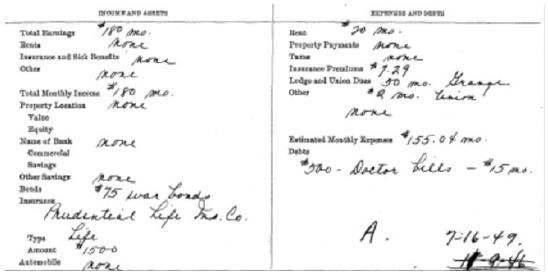
Figure 3 Economic data from an admission record Figure 4 Example of handwriting from a 1920s CSH patient